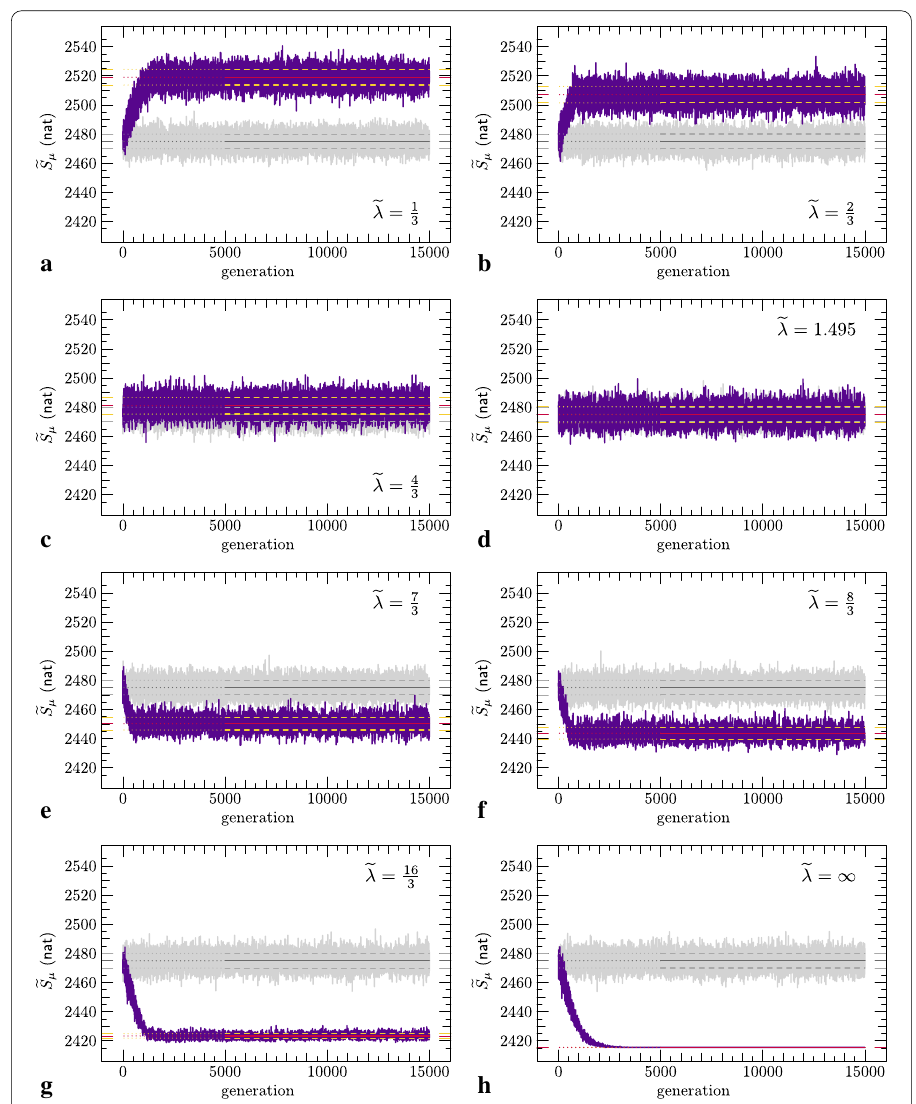
Fig. 6 Typical single-junction-switch Metropolis generation series for Central London (United Kingdom): (cid:31) = 2 (cid:31) υ , typical the foreground purple generation series plot, for different effective scaling exponents simulations starting from a self-fit output; the background light-grey generation series plot, according to (cid:31) the same modus operandi , typical sequences of self-fit outputs. Each horizontal solid line drawn along a generation series plot represents its in-equilibrium mean value, the accompanying horizontal dashed lines indicate the associated standard-deviation bounds. Coloured lines, Metropolis generation series; greyed lines, sequences of self-fit outputs. The equilibria are assumed reached after the 5000th generation. The following (cid:31) (cid:31) : − 3 and annealing parameters were used to algebraically cool down to the desired 0 = 1.495 , ǫ = 10 (cid:31) m = 500 . ( The starting cooling value 0 was chosen by hand so that the associated Metropolis equilibrium (cid:31) = ∞ in (h) corresponds to a (cid:31) (cid:31) approaches on average self-fit outputs—as illustrated in (d); the special case (cid:31) full ‘simulated annealing’ process (Press et al 2007; Galassi et al 2009). (cid:31)